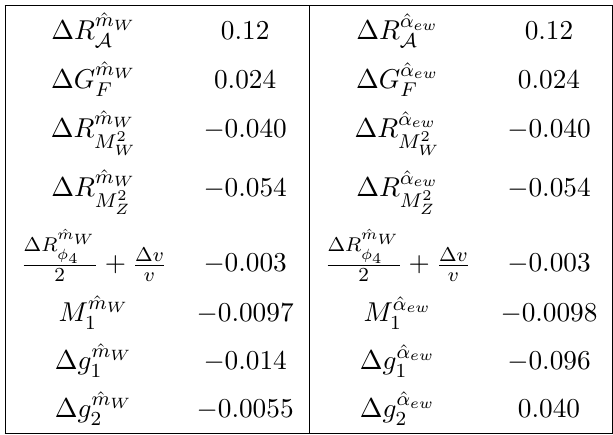
Table 2 . Numerical values of the one loop corrections to various Lagrangian parameters and matrix element corrections in both input schemes. We only report gauge independent combinations of parameters. We have chosen µ = ˆ m h in these evaluations for the scale dependence associated with the one loop improvement of input parameters and finite on shell renormalization conditions in the LSZ formula. For operator mixing effects, we set µ = Λ